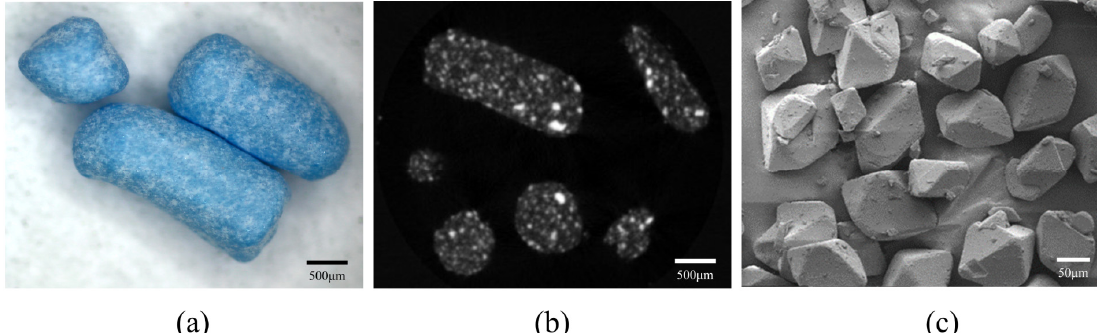
Figure 1. Morphology and microstructure of the polymer–crystal composite particles: ( a ) optical microscope image of the composite particles; ( b ) X-ray µ CT image of the composite particles; ( c ) scanning electron microscopy image of the